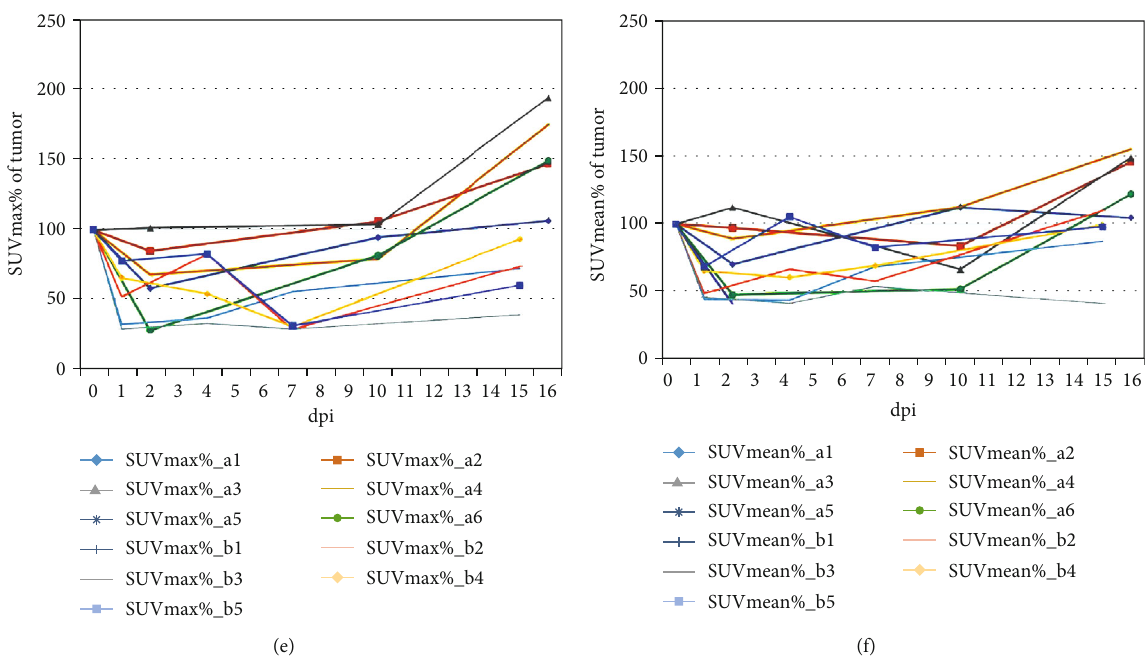
Figure 3: Changes in tumor volume and FDG uptake after bacterial cancer therapy (BCT) with engineered Salmonella typhimurium in a CT26 colon cancer cell line mouse model. Changes in tumor growth ratios (a), normalized tumor volume change (b), SUVmax (c), SUVmean (d), SUVmax% (e), and SUVmean% (f). Each point in the graphs represents a data measurement at that time point. (a) The tumor growth ratio was calculated as the measured volume divided by the initial volume (0 dpi). (b) Normalized volume change is calculated using tumorvolume ð 0 dpi Þ − tumorvolume ð x dpi Þ /tumorvolume ð 0dpi Þ (c, d) Changes in FDG uptake in the tumor are shown as SUVmax in (c) and SUVmean in (d). (e, f) Percent changes in FDG uptake are shown as SUVmax% in (e) and SUVmean% in (f). SUVmax% and SUVmean% are calculated as 100 × SUV ð specific dpi Þ /SUV ð 0 dpi Þ . Abbreviations: FDG, 2-deoxy-2[ 18 F] fl uoro-D- glucose; dpi, days post-injection; SUVmax, maximum standardized uptake value; SUVmean, mean standardized uptake